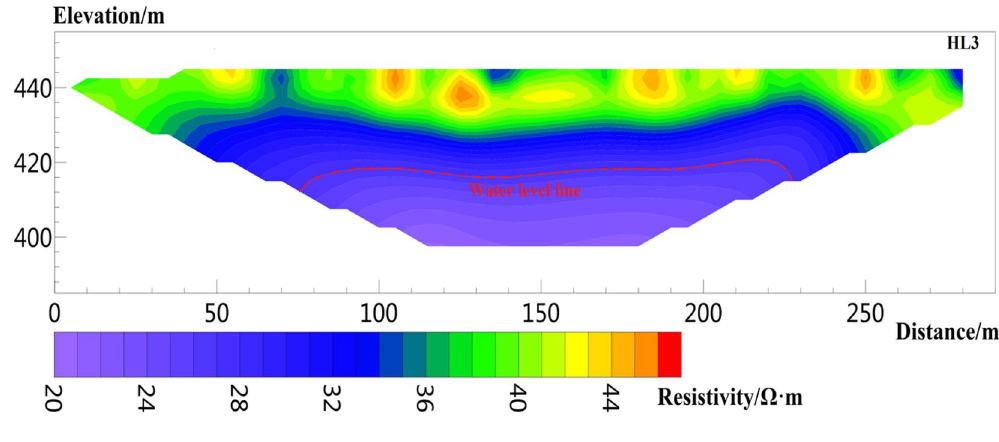
Figure 14. Resistivity profile of line